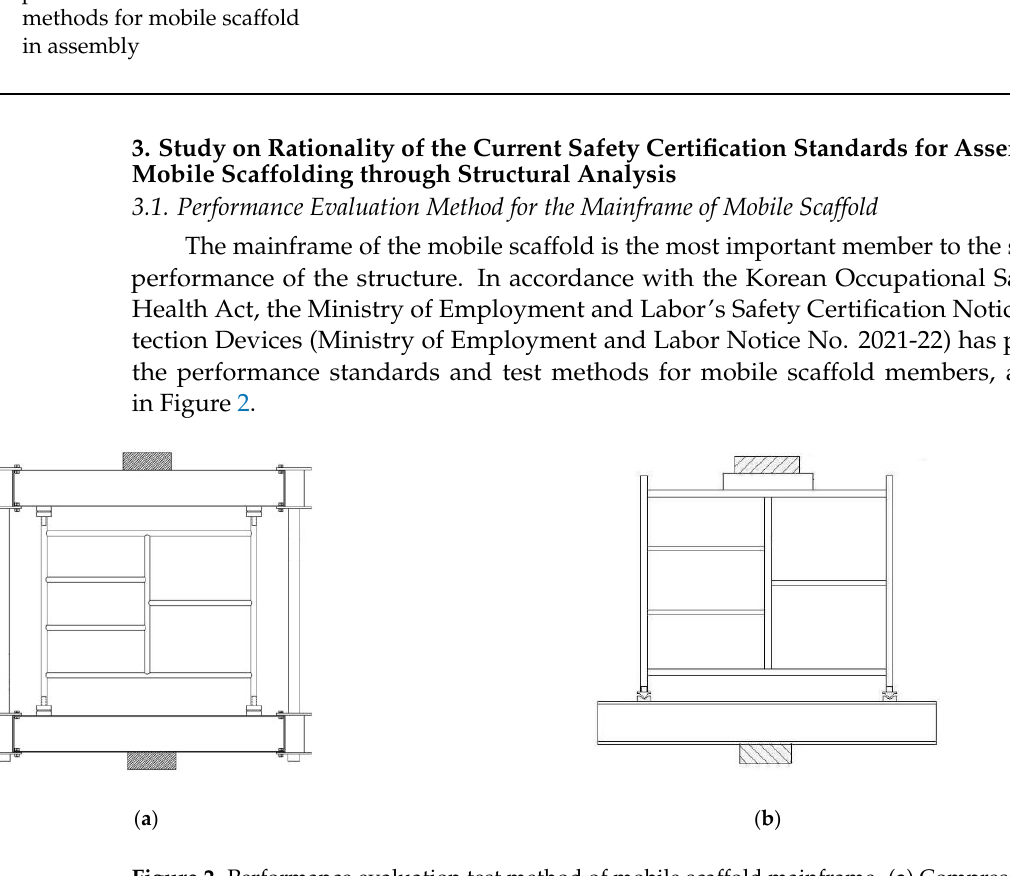
Figure 2. Performance evaluation test method of mobile scaffold mainframe. ( a ) Compression test of mainframe. ( b ) Deflection test of mainframe.